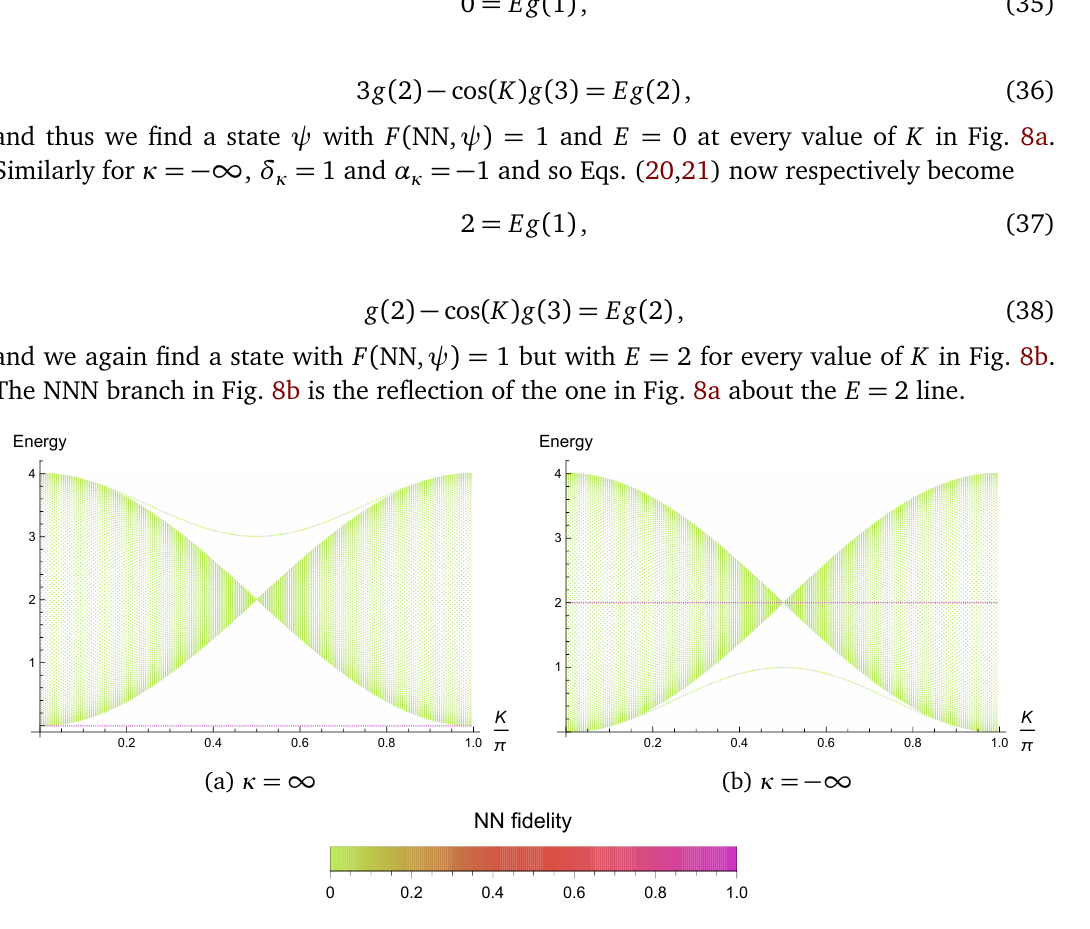
Figure 8: Two-magnon excitations and nearest neighbor fidelity for N = 200 and κ = ±∞ respectively in (a) and